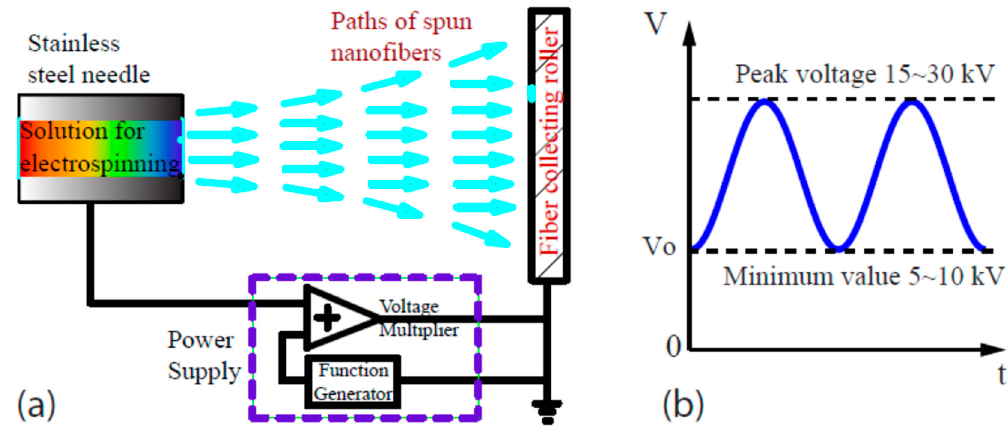
Figure 1. Schematic drawings: ( a ) nanofiber spinning set-up; ( b ) output voltage vs. time.